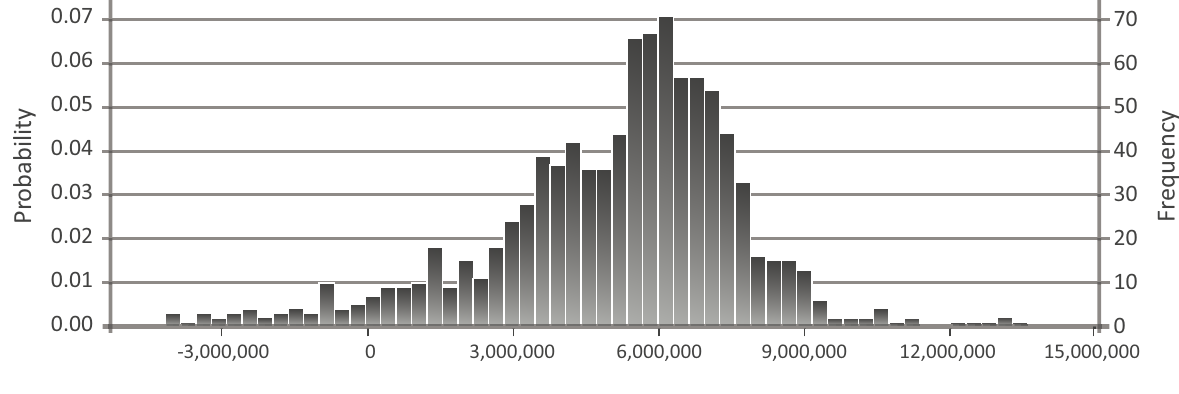
Figure 2. Probability distribution of the resulting value of the company –